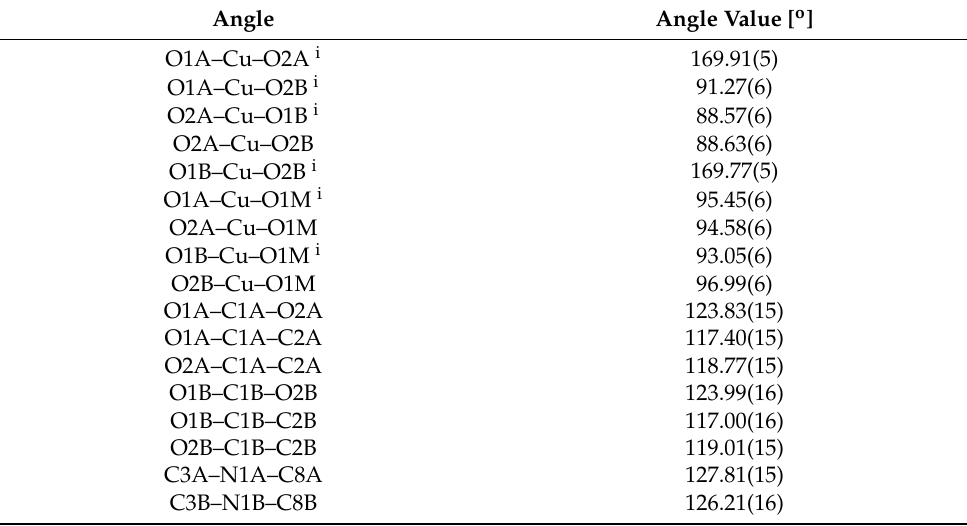
Table 3. Selected angles in [Cu II 2 (Tolf) 4 (MeOH) 2 ] · 2MeOH.